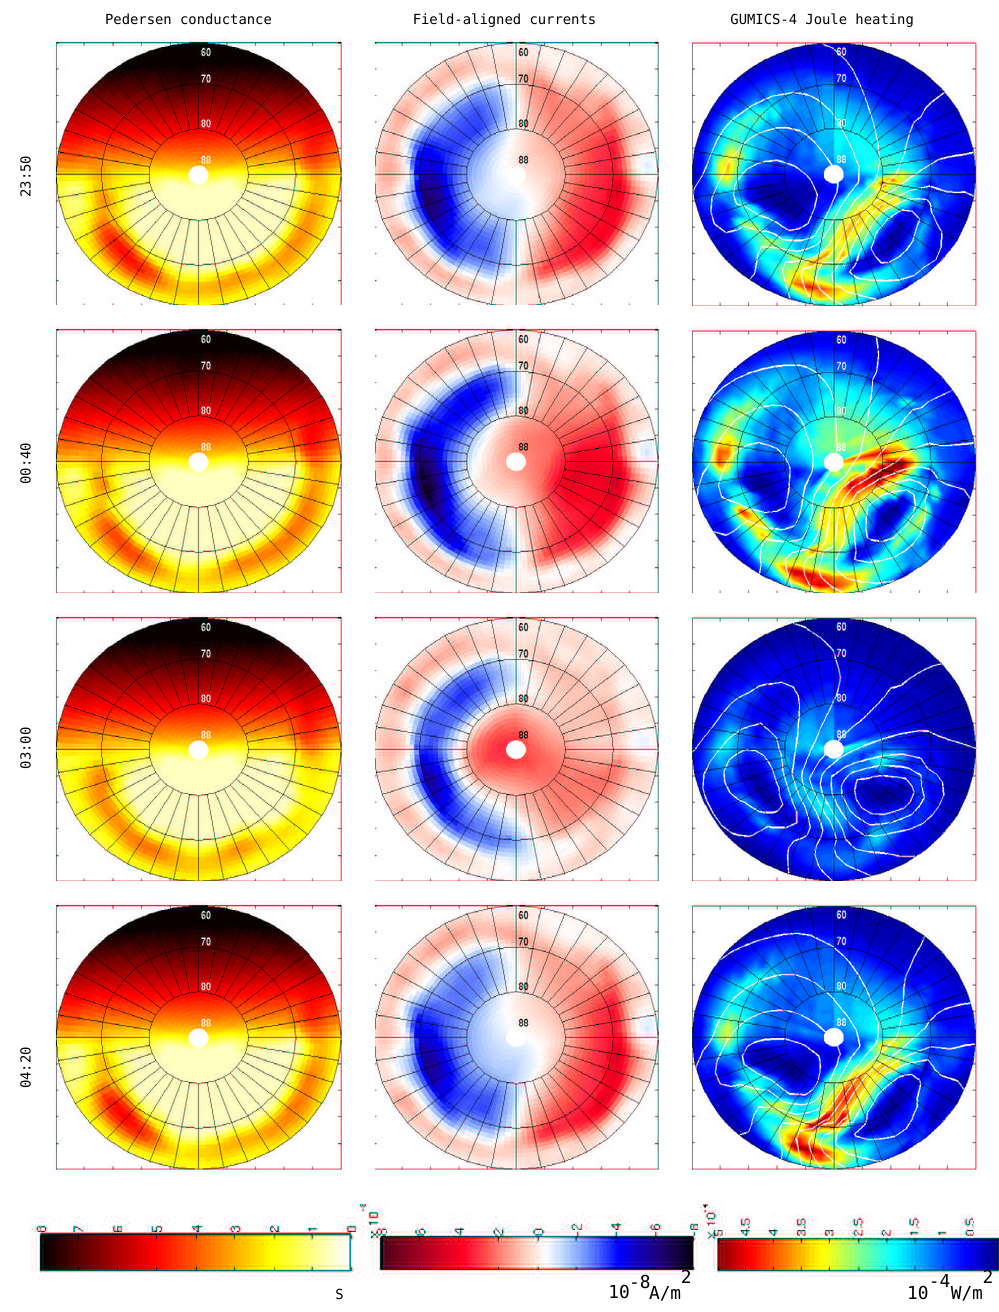
Fig. 8. Northern Hemispheric GUMICS-4 Pedersen conductance, field-aligned currents, and Joule heating (white contours are polar cap potential isocontours) at 23:50 UT, 00:40 UT, 03:00 UT, and 04:20 UT.